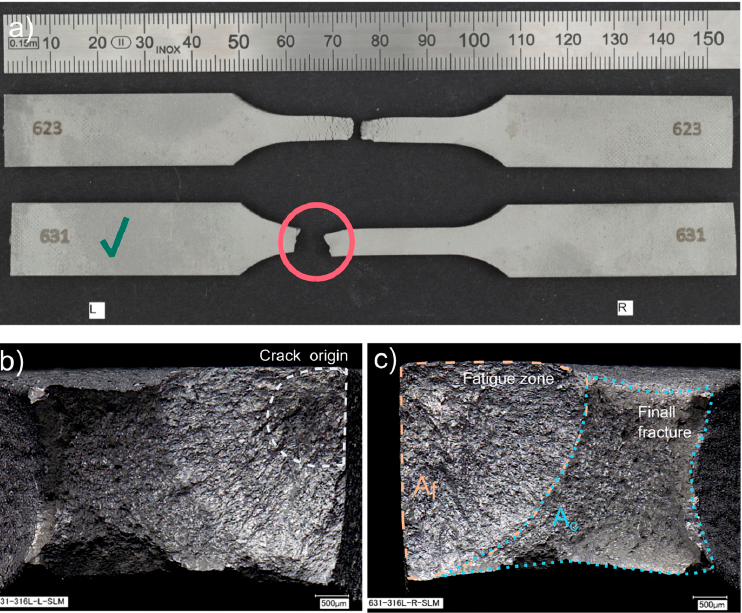
Figure 15. Fatigue fractures of Renishaw EOS M 290 316L samples: ( a ) fractured EOS M 290 316L specimens during the fatigue tests; ( b ) fracture surface (SEM image), left side, specimen 631, at 392,641 cycles; ( c ) fracture surface (SEM image), right side, specimen 631, at 392,641 cycles. The samples have been numbered, which are visible in the figure. The letters L and R stand for the left-hand and right-hand sides of the sample in the figure. A green check mark means the specimen whose fracture faces were